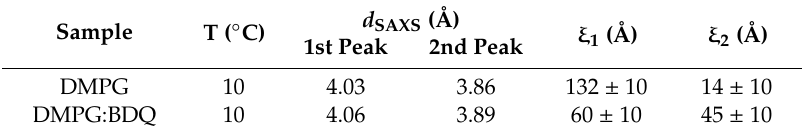
Table 6. WAXS di ff raction patterns of DMPG and DMPG with BDQ at 5% molar ratio at 10 ◦